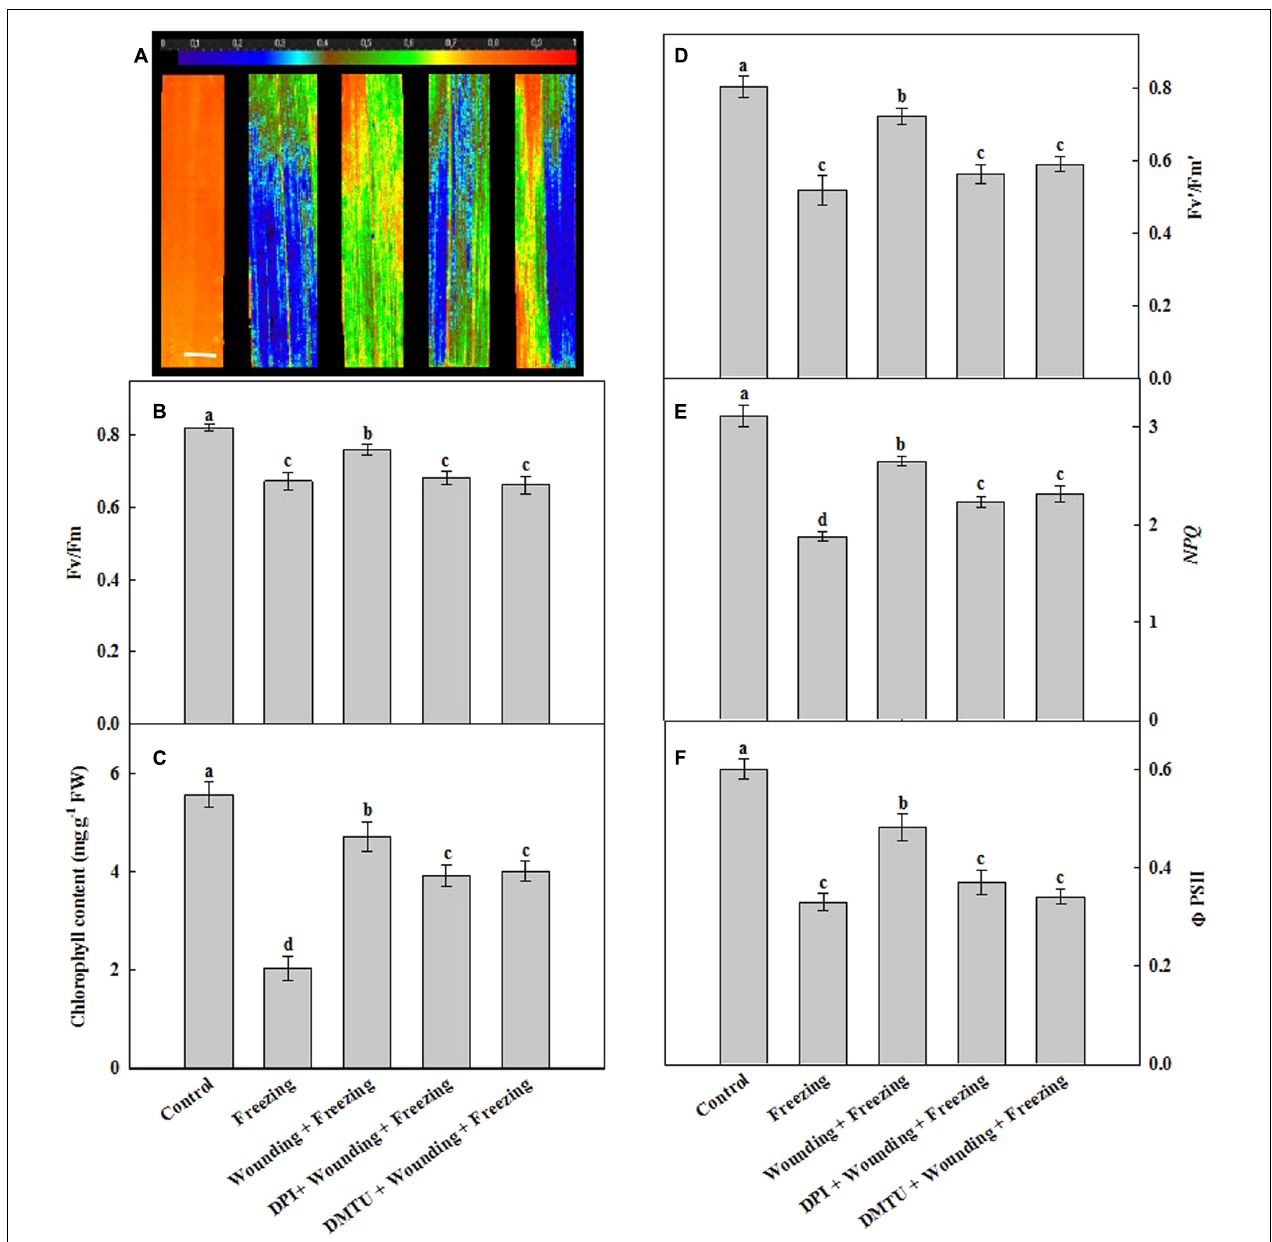
FIGURE 3 | Effects of mechanical wounding on chlorophyll fluorescence parameters and chlorophyll content in the local and the systemic leaves of wheat under freezing stress. The maximal photochemical efficiency of photosystem II (PSII) as indicated by Fv/Fm (A,B) , total chlorophyll content expressed in mg g − 1 FW (fresh weight) (C) , photochemical activity of PSII as indicated by Fv (cid:48) /Fm (cid:48) (D) , the non-photochemical quenching as indicated by NPQ (E) and the quantum yield of PSII as indicated by (cid:56) PSII (F) . The local (fifth) leaves were separately pre-treated with distilled water, 5 mM DMTU or 100 µ M DPI prior to wounding. At 10 days after wounding, the seedlings were exposed to freezing stress for 24 h. Chlorophyll fluorescence parameters were observed on the systemic (sixth) leaf as area of interest after 24 h recovery. Data are mean values ± SD of three independent replicates. Means denoted by different letters indicated significant difference at P < 0.05 according to Tukey’s test. Bar, 10